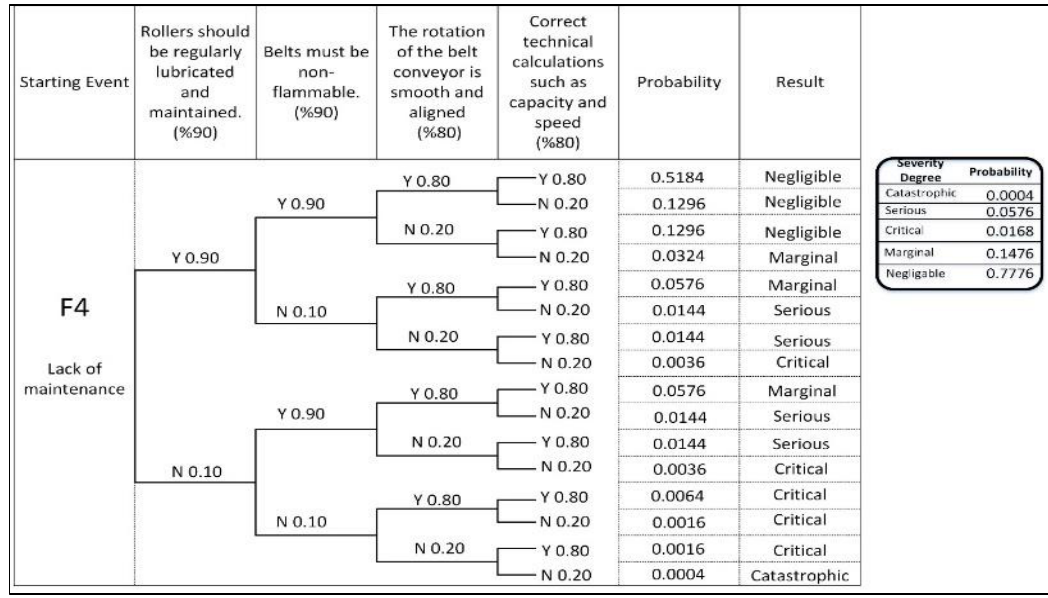
Figure 8: Event tree analysis diagram of